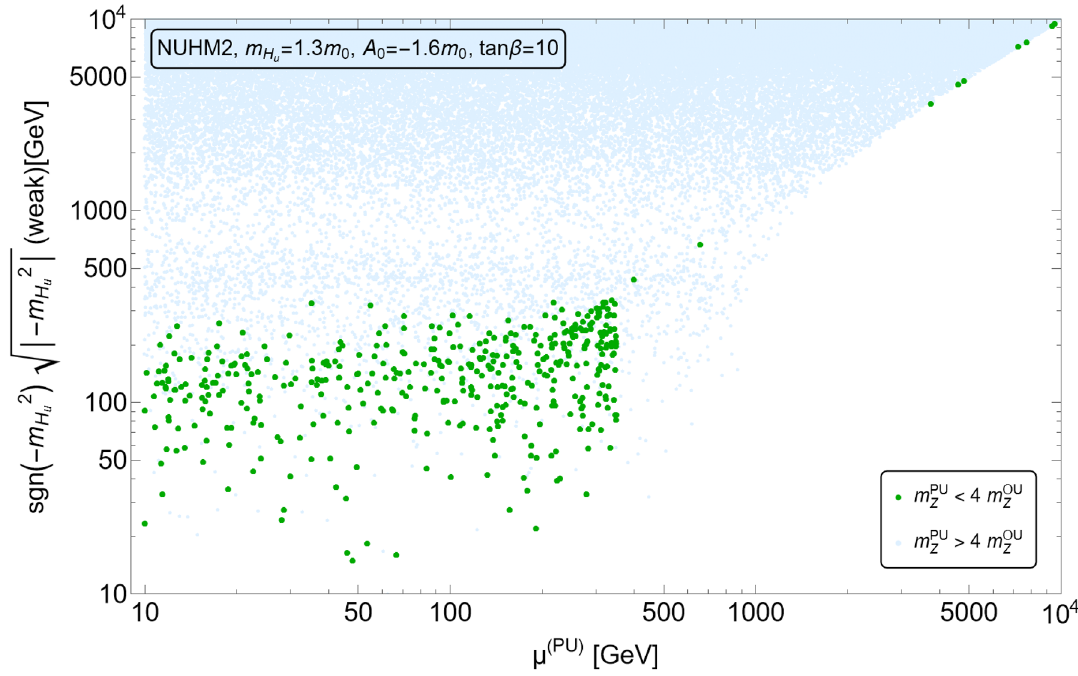
Figure 6. The value of m H ( weak ) vs. µ PU The green points denote vacua with appropriate EWSB u and with m PU < 4 m OU so that the atomic principle is satisfied. Blue points have m PU weak weak